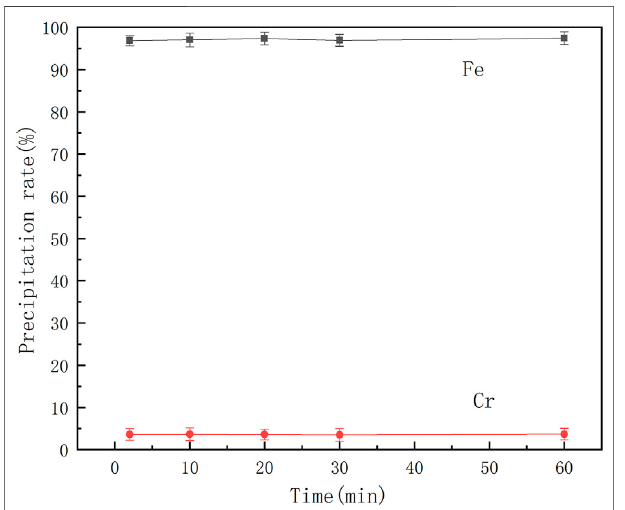
FIGURE 7 | Effect of benzoic acid dosage on the separation of